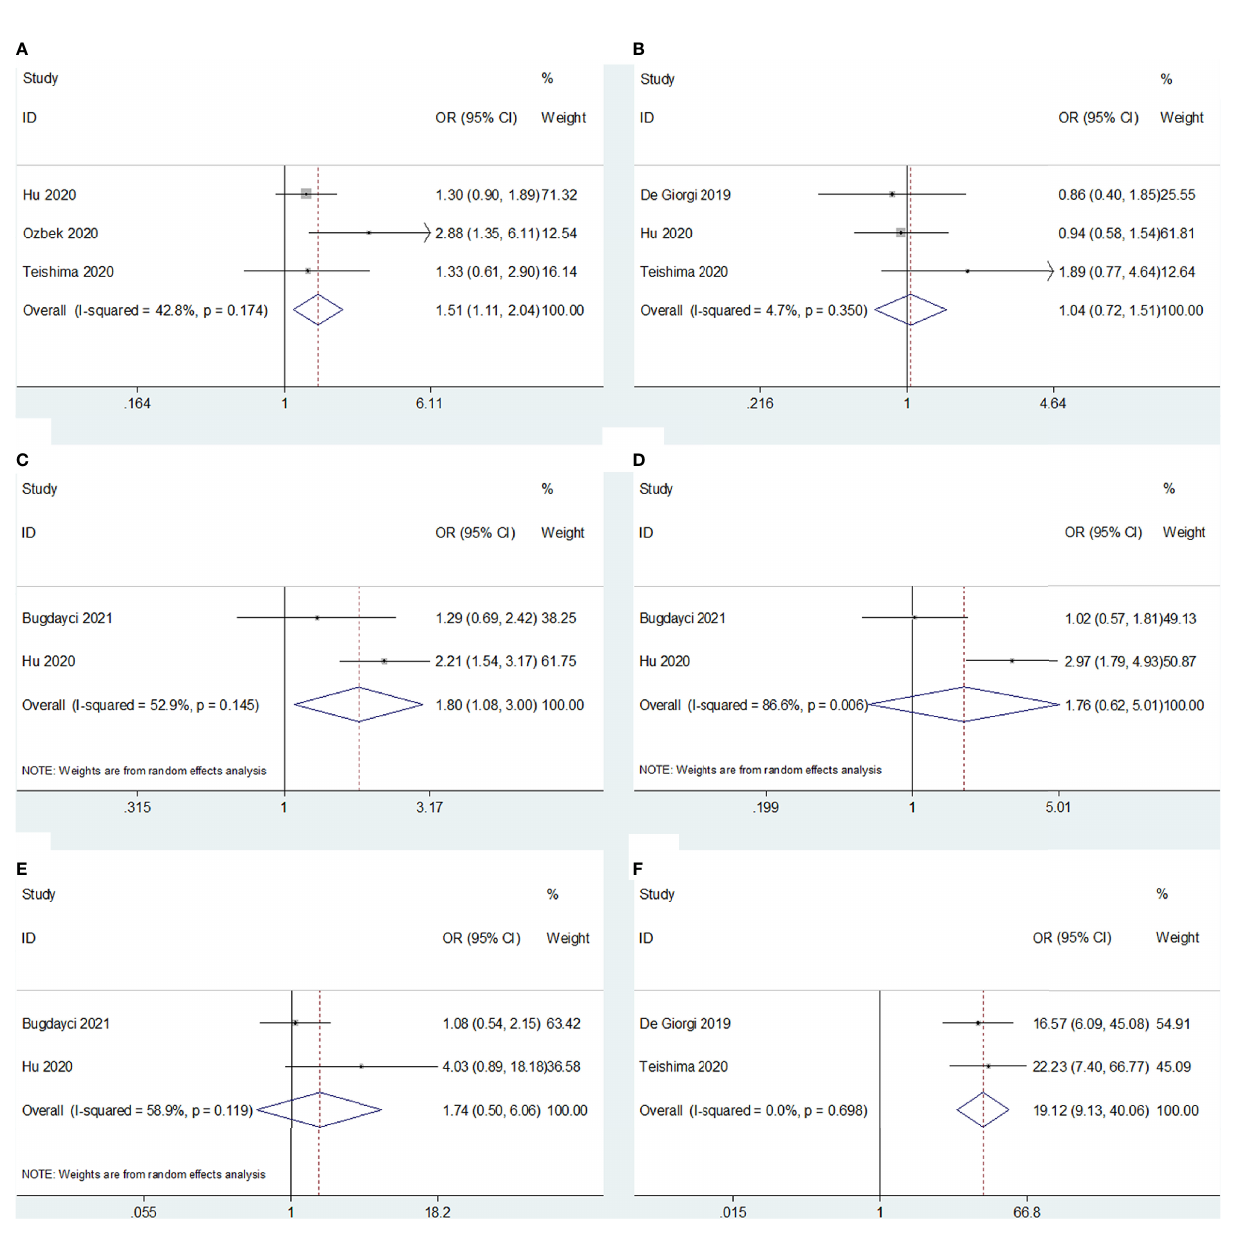
FIGURE 5 | Forest plots of the association between SII and clinicopathological features of RCC. (A) Sex; (B) Histological type; (C) Fuhrman grade; (D) T stage; (E) Sarcomatoid differentiation, and (F) IMDC risk.